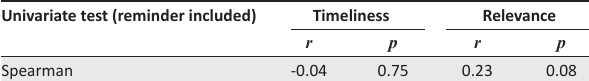
TABLE 6: Univariate results of market-book value ratio. Univariate test (reminder included)